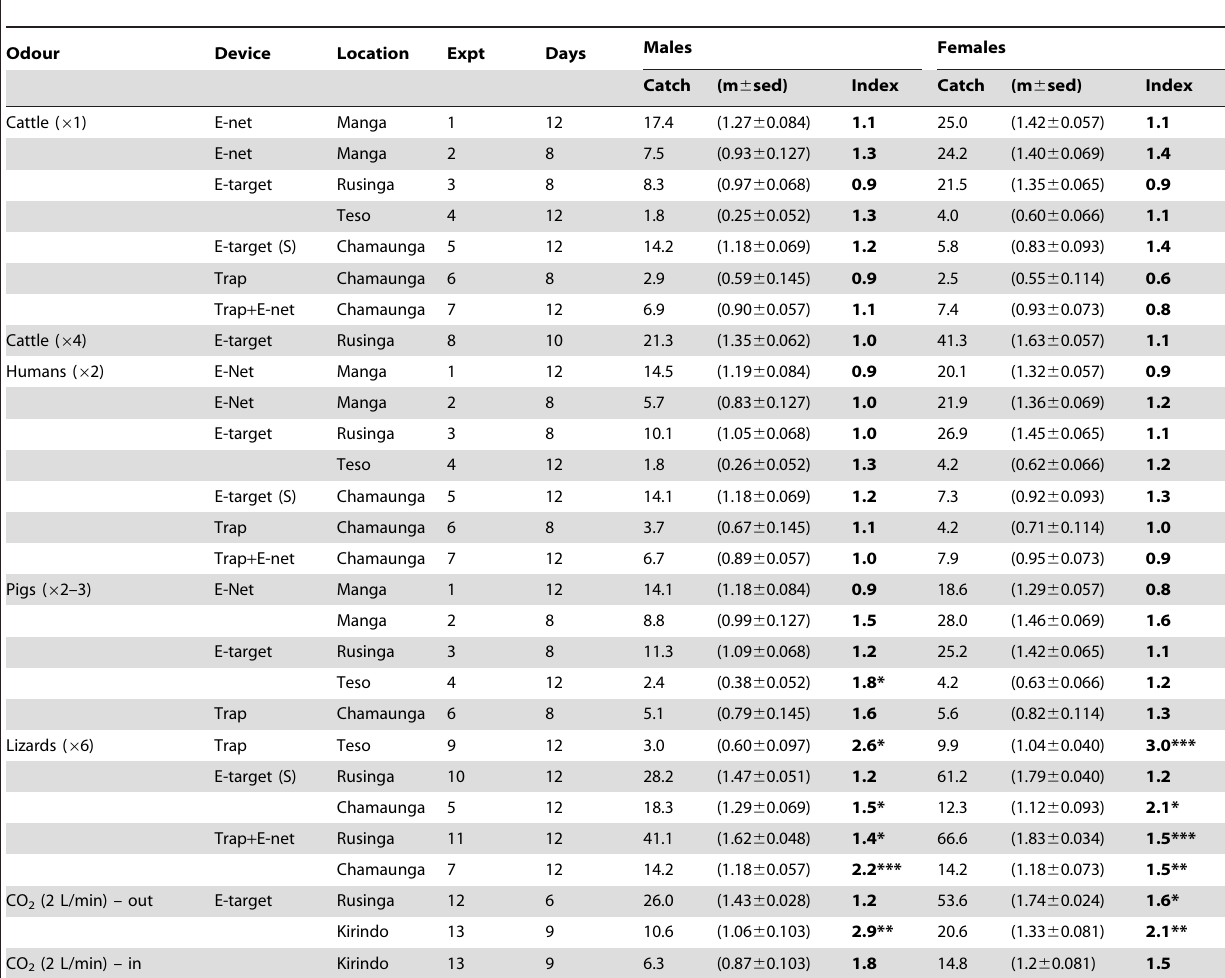
Table 1. Detransformed mean daily catches (transformed mean and standard error of the difference (SED) shown in brackets) of G. f. fuscipes caught over n days from odour-baited devices at various locations in western Kenya.